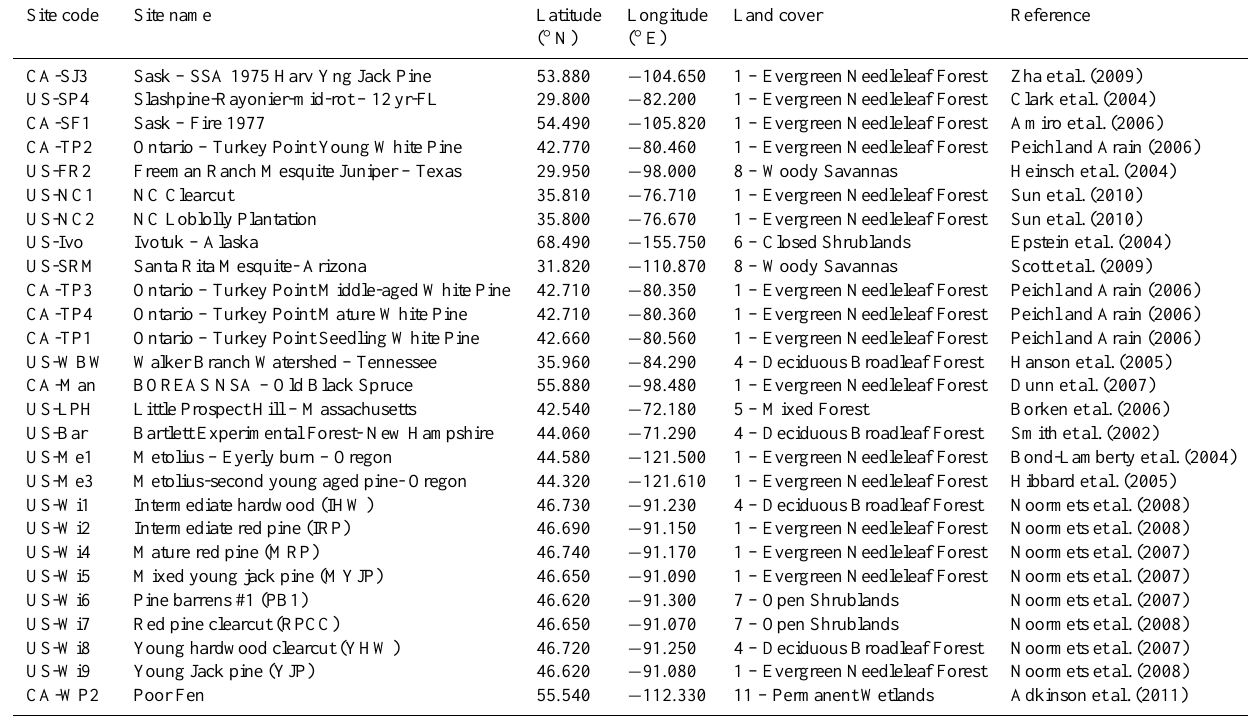
Table 2. 27 North American eddy covariance cross-validation